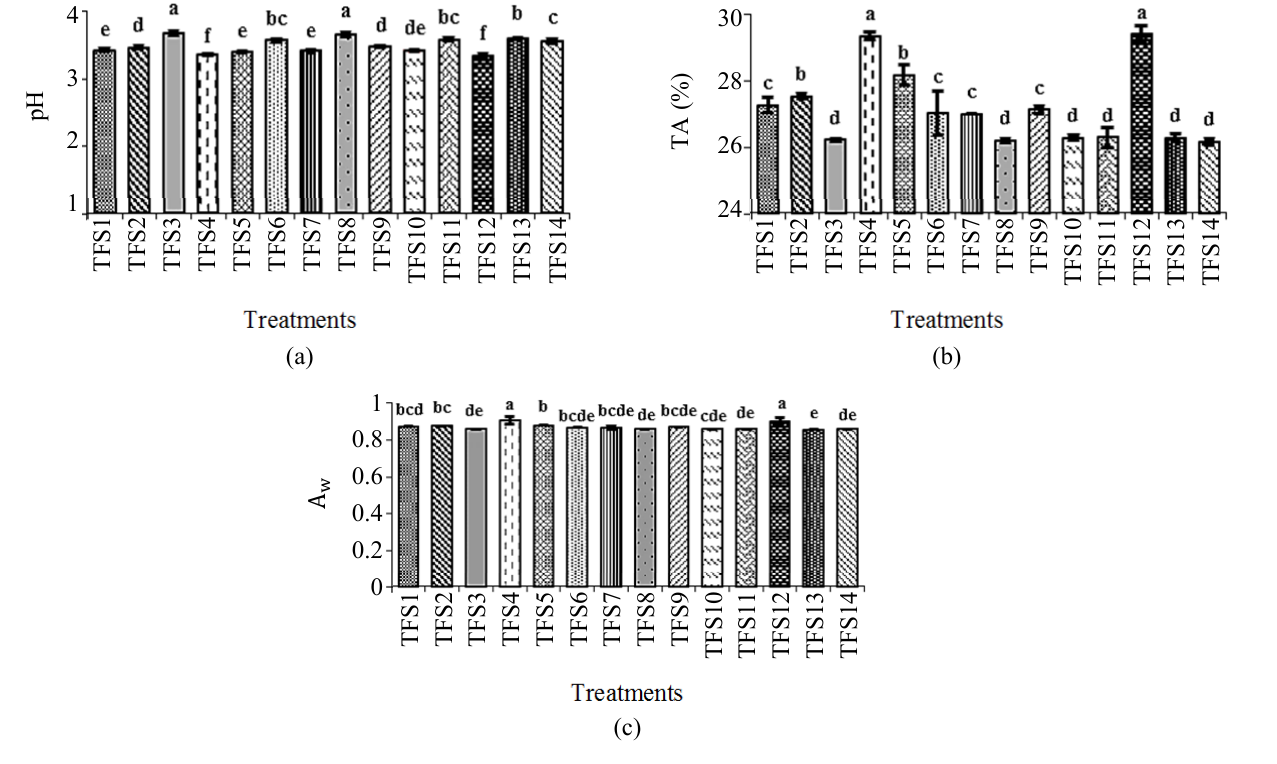
Fig. 1. Chemical properties of Vietnamese tamarind fish sauces.